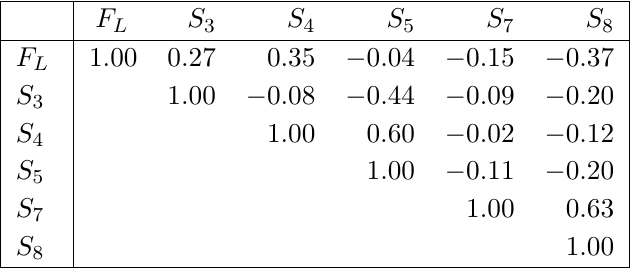
and S parameters obtained for q 2 2 L